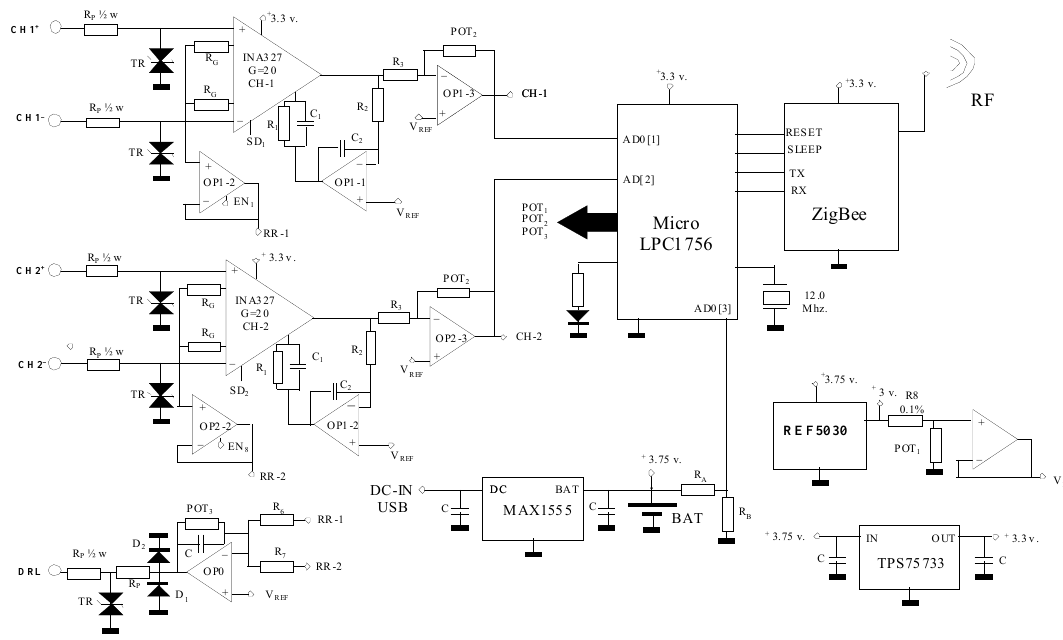
Figure 3. Electrical system diagram.